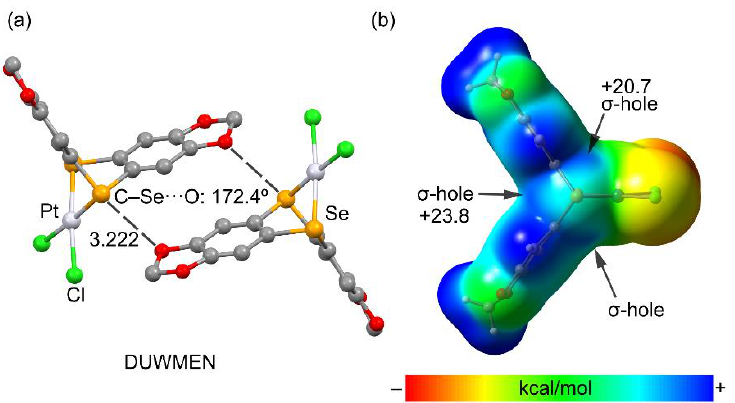
Figure 3. ( a ) Partial view of refcode DUWMEN structure. Distance in Å . H-atoms omitted for clarity. ( b ) MEP surface (isodensity 0.001 a.u.) of DUWMEN. The energies at the σ -holes are indicated in kcal/mol.